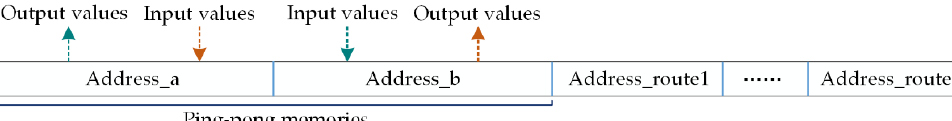
Figure 11. The diagram of the parameter storage module, which is composed of a Double Data Rate (DDR) controller and parameters buffer.